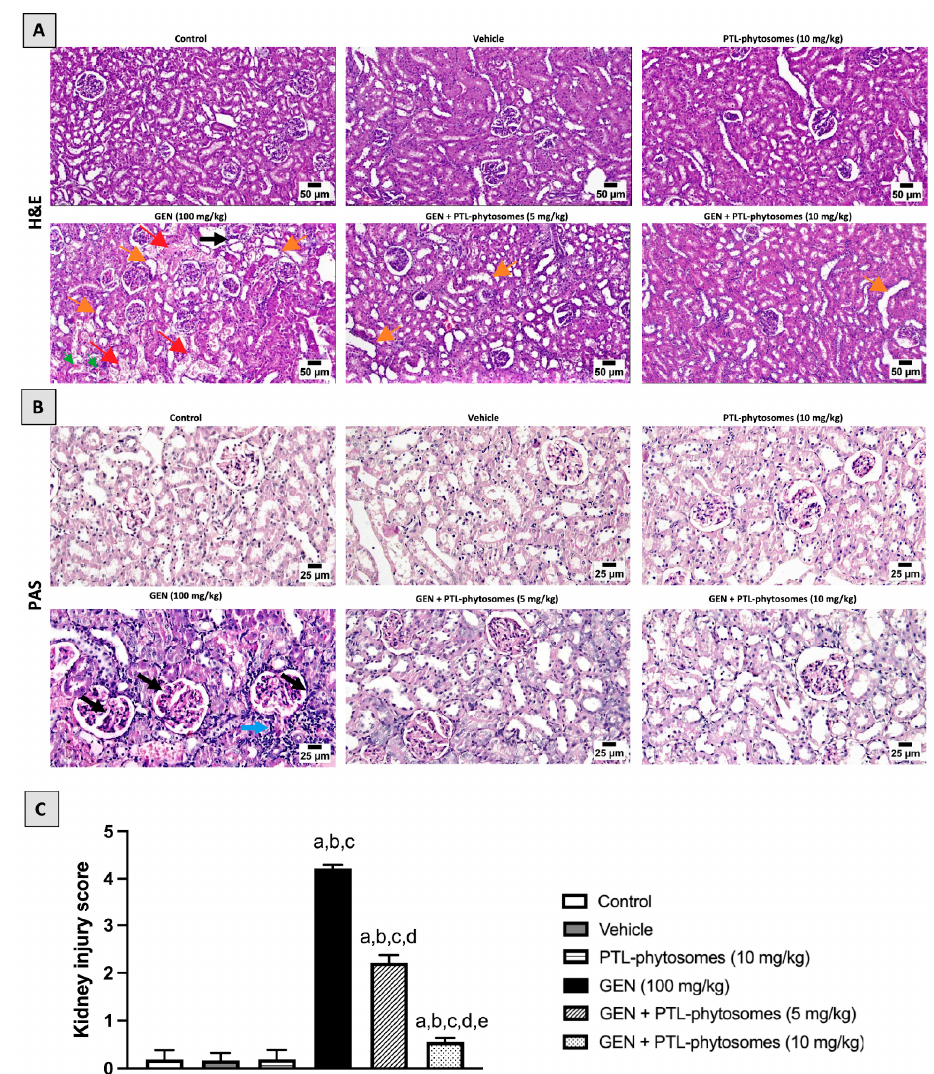
Figure 4. PTL-phytosomes inhibited GEN-induced kidney damage. Photomicrographs of kidney sections stained with H&E and PAS stains from different groups of experimental animals. ( A ) In the H&E-stained section, GEN-induced tubular necrosis (red arrows), peritubular inflammatory cell infiltration (black arrow), tubular dilatations (orange arrows), and cast formation (green arrowhead) were observed. Conversely, the co-treatment of PTL-phytosomes (5 or 10 mg/kg) with GEN notably improved histoarchitecture of glomerulus and tubules, except for a few tubular dilatations in kid- ney tissue observed (orange arrows), scale bar 50 µ m. ( B ) In the PAS-stained section, GEN caused extensive structural glomerular damage (black arrows) and Bowman’s capsule rupture with inflam- matory cell infiltration (blue arrow). However, these alterations were less severe in co-treatment of PTL-phytosomes (5 or 10 mg/kg) + GEN, scale bar 25 µ m. ( C ) Kidney injury score was evaluated. Data are expressed as Mean ± SD ( n = 6). a: significant when compared to control at p < 0.05; b: significant when compared to vehicle at p < 0.05; c: significant when compared to